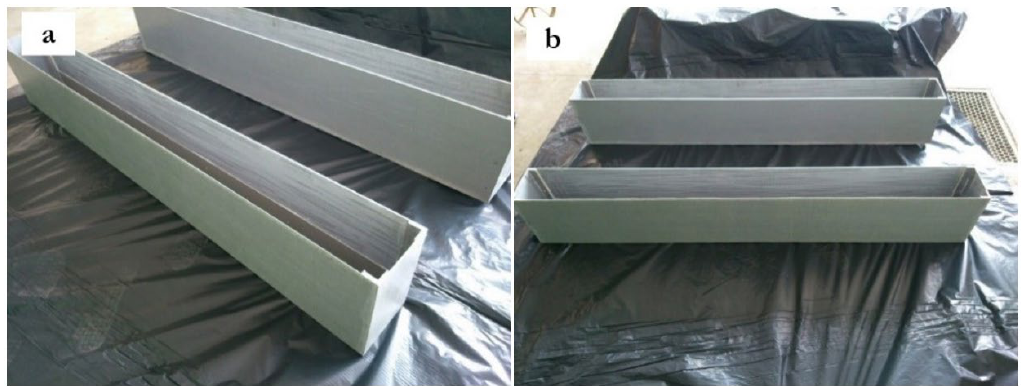
Figure 5. GFRP profiles used in groups D and